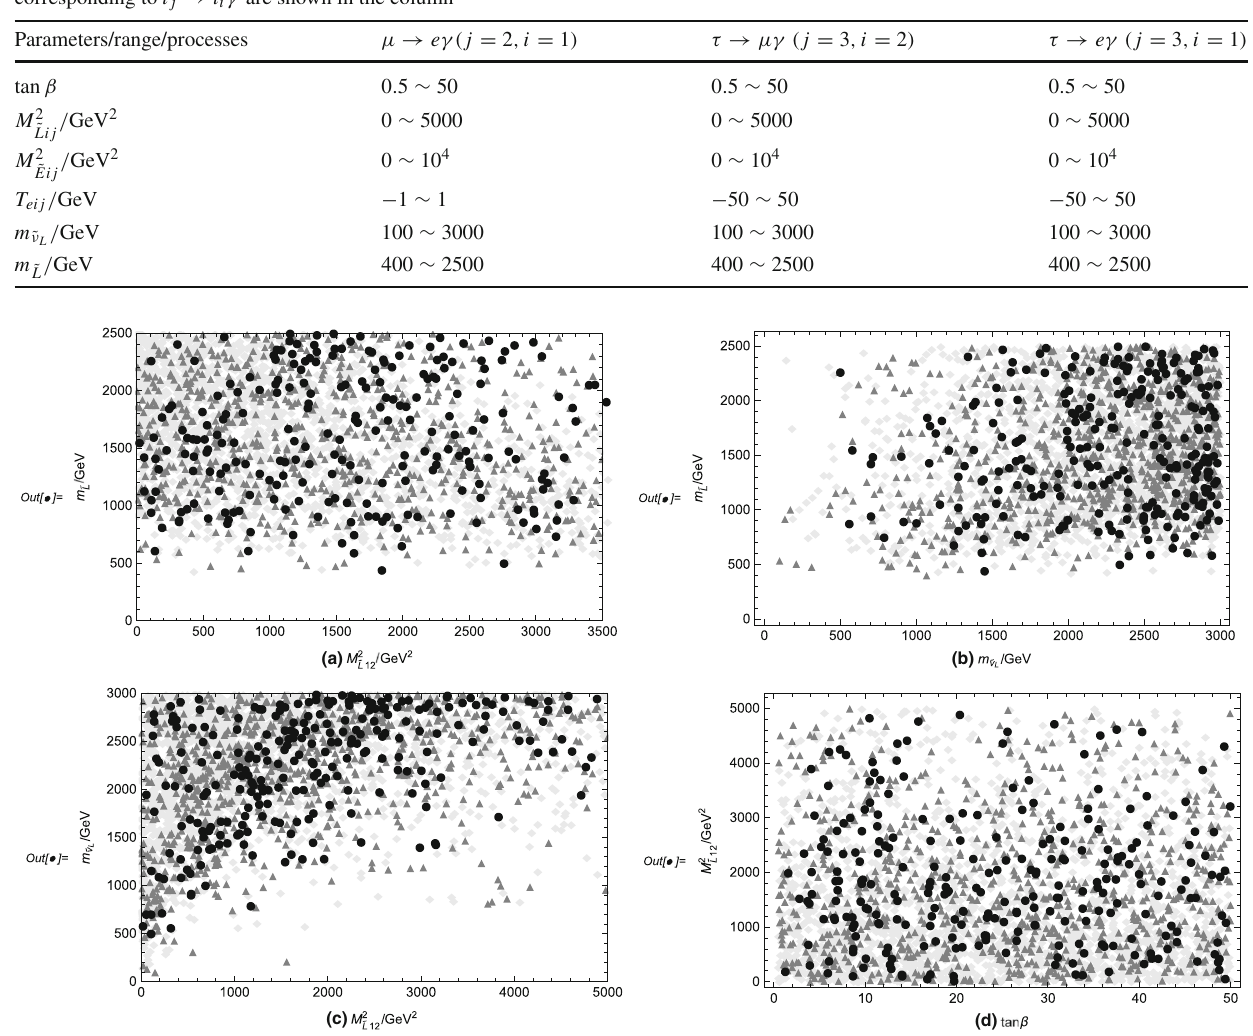
, m 2 , T eij ˜ Eij Lij